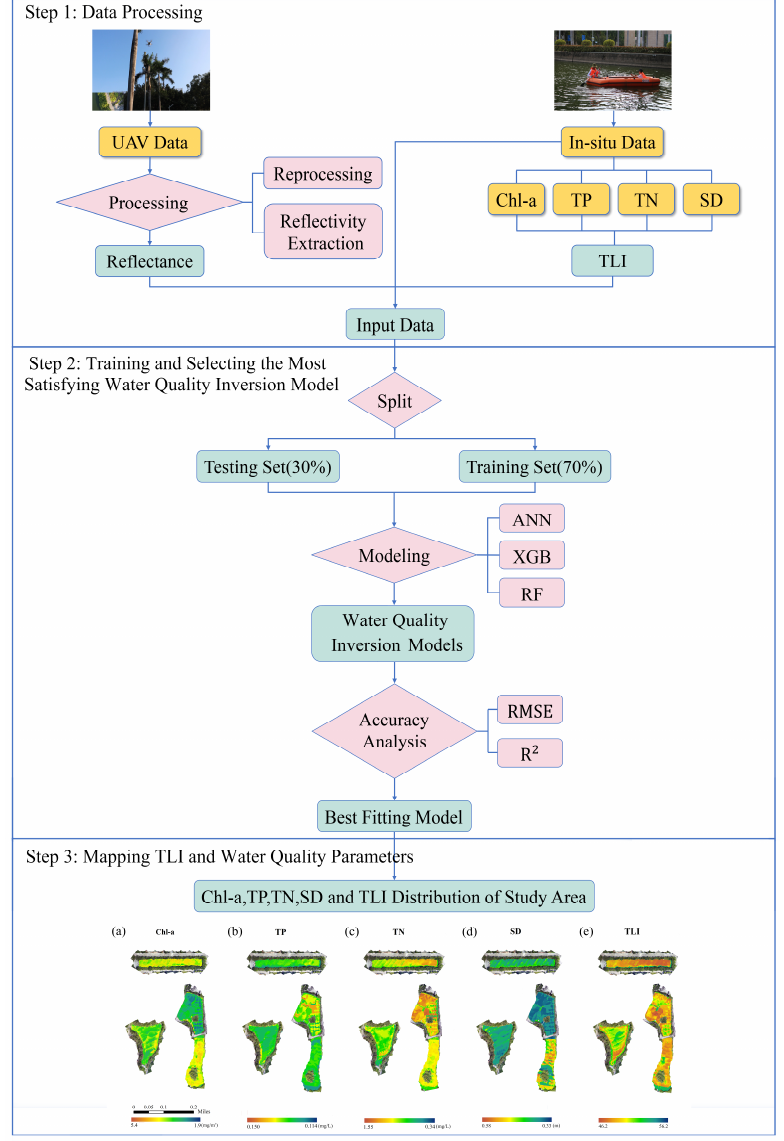
Figure 2. Workflow for image processing, data analysis and modeling. Spatial distribution of different water quality parameters based on the XGB model in step 3: (a) Chl-a , (b) TP , (c) TN , (d) SD , (e) TLI . After exporting the processed remote images, ENVI, a remote sensing image process- ing platform, was used to read the reflectivity of the five bands at 45 sampling